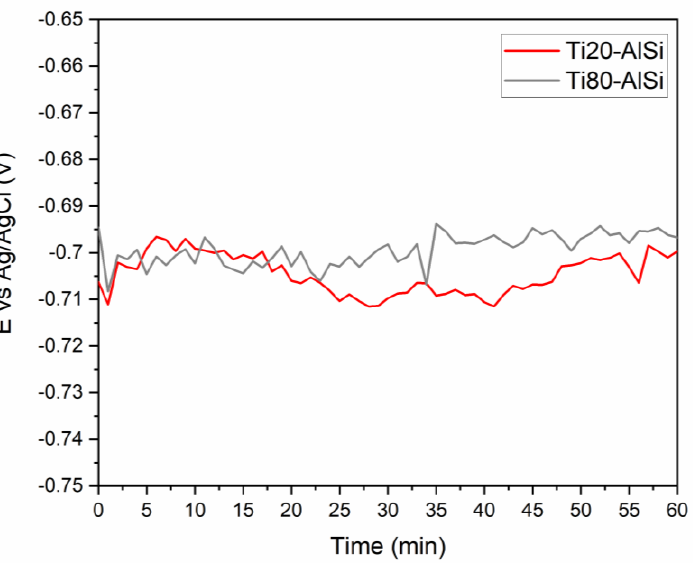
Figure 8. The open-circuit potential trend over time for the Ti80–AlSi (red line) and Ti80–AlSi (grey line) samples.